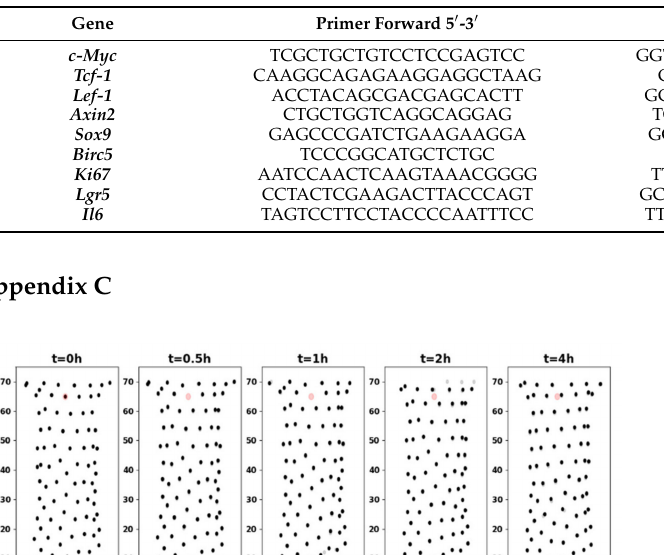
Table A1. Examined genes and used primers to study expression changes in mouse colonoids by quantitative RT-PCR.